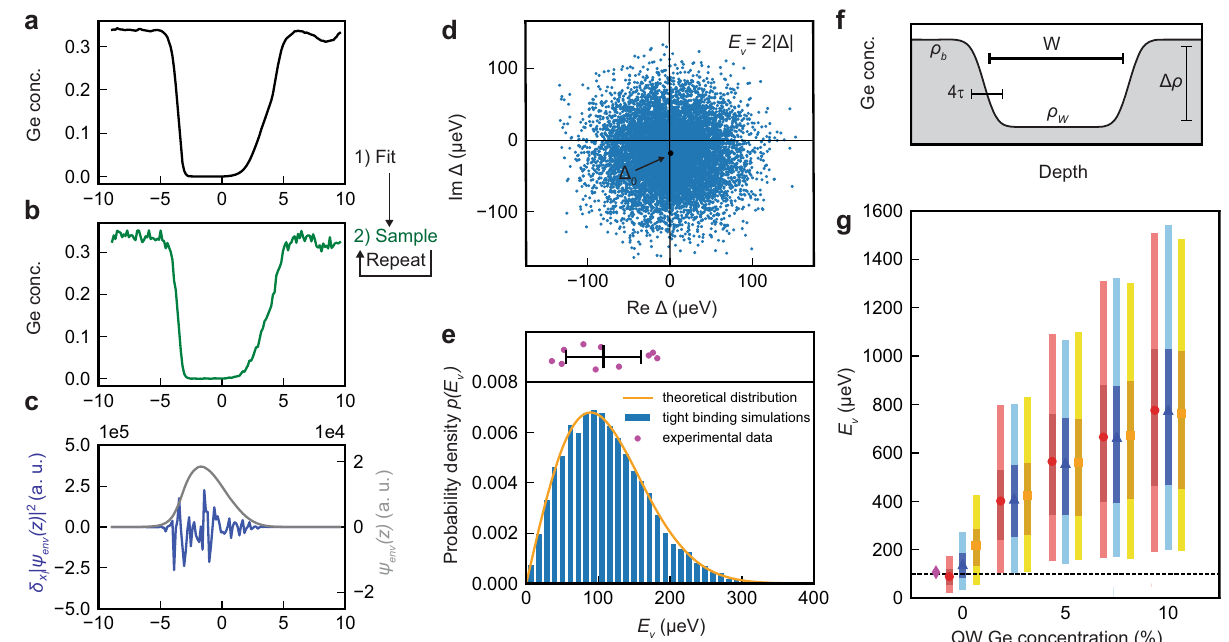
Fig. 3 | Valley-splitting simulations. a Average concentration pro fi le obtained effective-mass calculations (see Methods). f Schematic Si/SiGe quantum well with from APT data (quantum well A). b Typical, randomized Ge concentration pro fi le, Ge concentrations ρ W (in the well) and ρ b = ρ W + Δ ρ (in the barriers), with a fi xed concentration difference of Δ ρ =25%. g Distribution of valley splittings obtained derivedfrom a . c Envelopefunction ψ env ( z ),obtainedfortherandomizedpro fi lein b (grey curve), and the corresponding concentration fl uctuations weighted by the from simulations with variable Ge concentrations, corresponding to ρ W ranging ∣ ψ ð z Þ ∣ 2 (blue). Here, the wavefunction is con- from0to10%,andinterfacewidths4 τ =5ML(redcircles),10ML(bluetriangles),or envelope function squared: δ x env l l centrated near the top interface where the concentration fl uctuations are also 20ML (orange squares), where ML refers to atomic monolayers. Here, the marker large; the weighted fl uctuations are therefore the largest in this regime. describes the mean valley splitting, while the darker bars represent the 25-75 per- d Distribution of the intervalley matrix element Δ in the complex plane, as com- centile range and the lighter bars represent the 5 – 95 percentile range. Each bar puted using an effective-mass approach, for 10,000 randomized concentration re fl ects 2000 randomized tight-binding simulations of a quantum well of width pro fi les. The black marker indicates the deterministic value of the matrix element W =120ML. The magenta diamond at zero Ge concentration shows the average fi le in a . e Histogram of the valley splittings Δ measured valley splitting of quantum well A. In all simulations reported here, we 0 , obtained for the experimental pro fromtight-bindingsimulationswith10,000randomizedpro fi les.Thesamepro fi les assume an electric fi eld of E =0.0075V/nm and a parabolic single-electron quan- maybeusedtocomputevalleysplittingsusingeffective-massmethods;theorange p ffiffiffiffiffiffiffiffiffiffiffiffiffiffi _ = m * ω curve shows a Rice distribution whose parameters are obtained from such corresponding dot radius Fig. 3c,we compute δ Δ l using the randomized density pro fi le of Fig. 3b (blue curve). We see that most signi fi cant fl uctuations occur near the top interface, where ∣ ψ env ( z l ) ∣ and the Ge content of the quantum well are both large. In Fig. 3d we plot Δ values obtained for 10,000